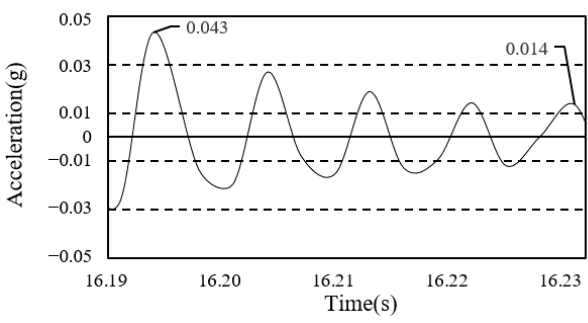
Figure 9. Damping ratio (cladding completion).